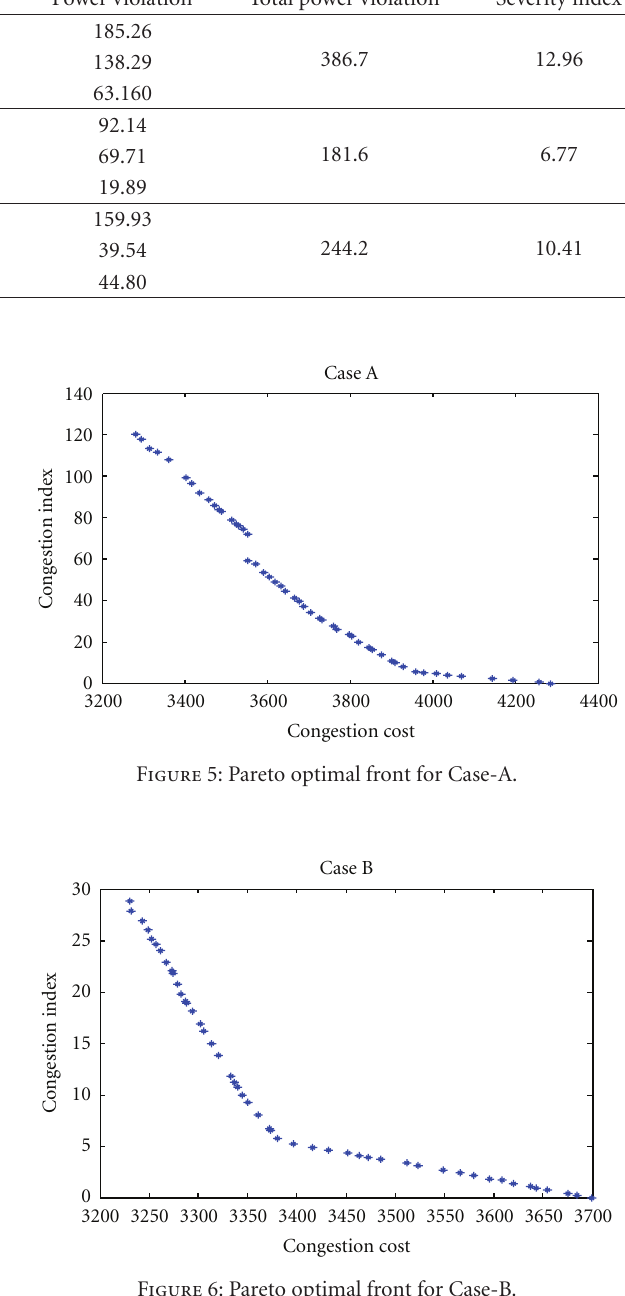
Figure 6: Pareto optimal front for